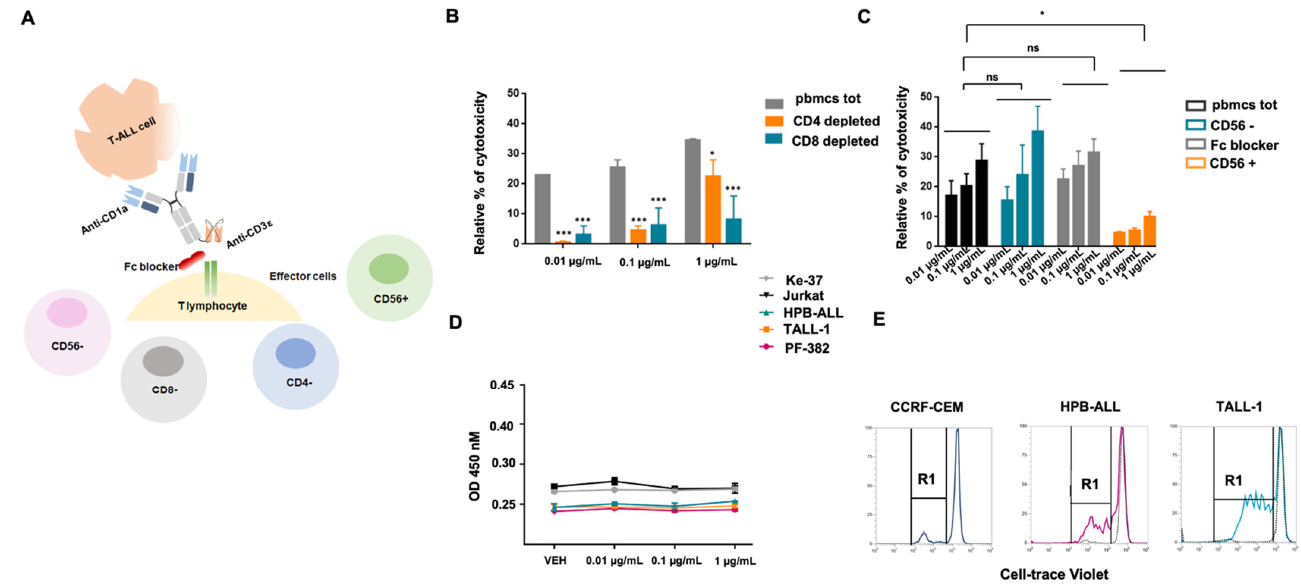
Figure 4. CD1a x CD3 ε BTCE in vitro activity is mediated by T cell. ( A ) Schematic representation of experimental design. ( B ) Relative percentage (%) of T-cell redirected cytotoxicity of PBMCs, CD4, and CD8 depleted lymphocytes co-cultured with T-ALL cells in the presence of increasing concentrations of the BTCE. ( C ) Relative percentage (%) of T-cell redirected cytotoxicity of PBMCs, CD56 depleted, CD56 enriched, and PBMCS Fc blocked co-cultured with T-ALL cells in the presence of increasing concentration (0.01,0.1 and 1 µ g/mL) of the BTCE. ( D ) CD1a x CD3 ε BTCE direct cytotoxicity in the absence of effector cells on T-ALL cell lines. ( E ) Proliferation of T-cells co-cultured with CCRF-CEM, HPB-ALL, and TALL-1 cells, respectively, in the presence of the BTCE. * p < 0.05, *** p < 0.001. Taking these results together indicates that CD1a x CD3 ε exerts T-cell mediated